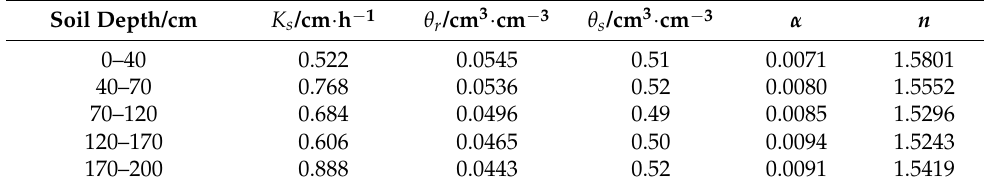
Table 3. Soil hydraulic parameters of experimental plot soil.